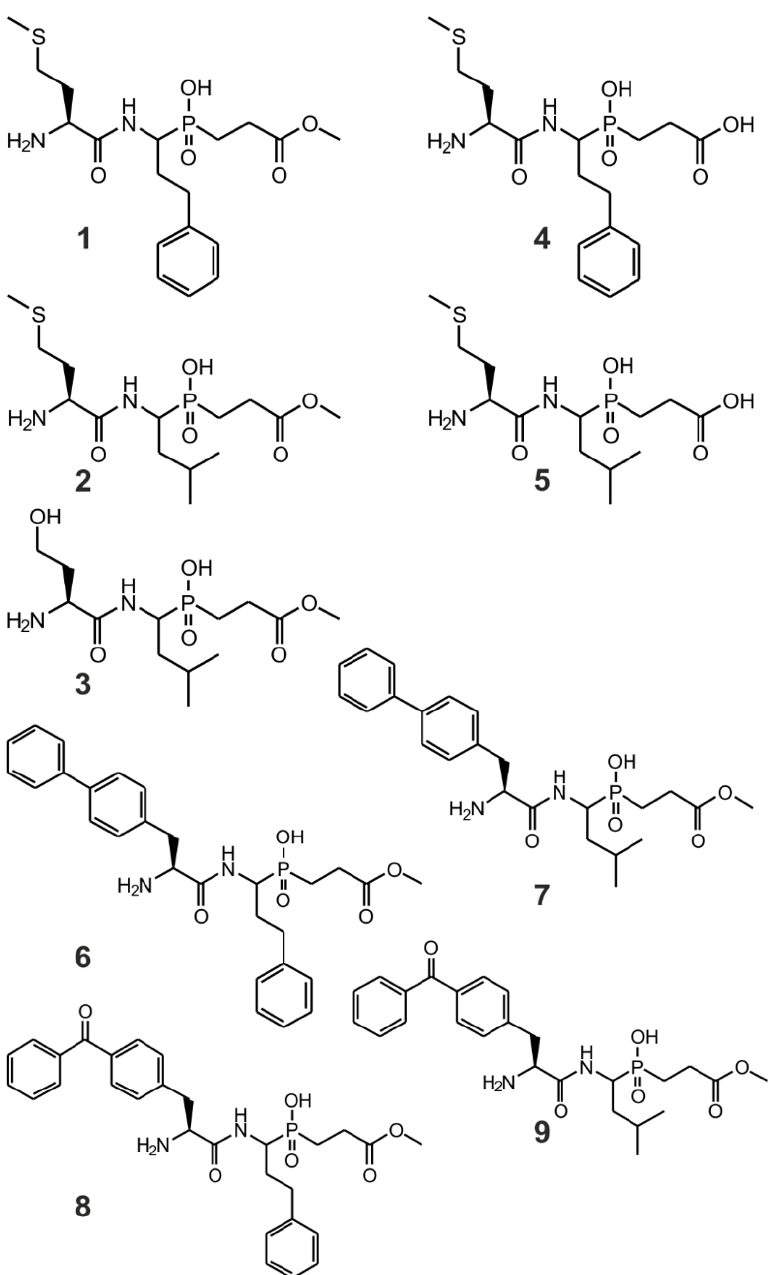
Figure 2. Putative phosphinic pseudotripeptides derived from leucine and homophenylalanine containing modified P2 substituents as inhibitors of leucylaminopeptidase.